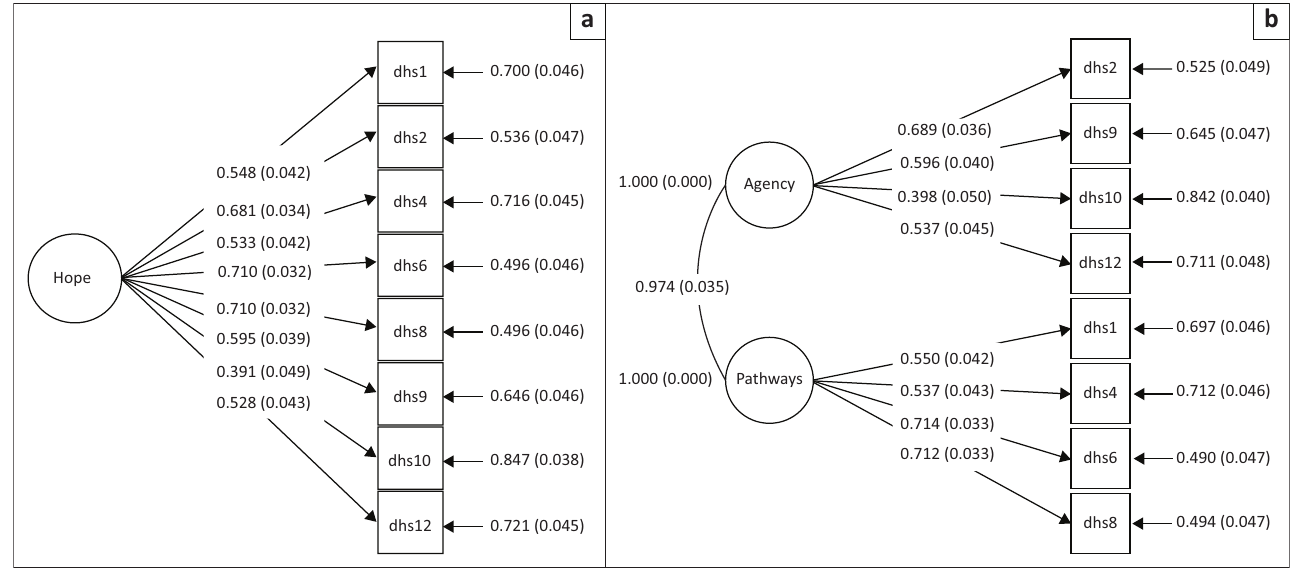
FIGURE 1 : The confirmatory factor analysis (CFA) models for sample 1 ( n = 383). (a) The unidimensional solution, and, (b) the two-factor solution. TABLE 2 : Descriptive statistics: Sample 1 ( n = 383), based on confirmatory factor analysis two-factor model. Variable Mean Variance Minimum